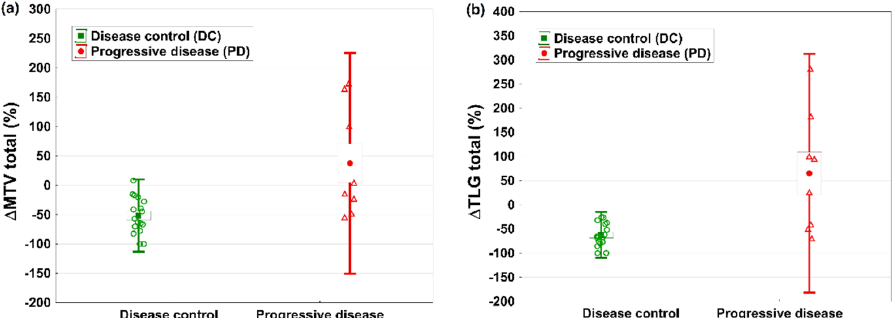
Figure 1. Mean changes in PET parameters ( a ) metabolic tumor volume (MTV) and ( b ) total lesion glycolysis (TLG) in patients with DC and PD according to EORTC; EORTC = European Organization for Research and Treatment of Cancer; DC = disease control; PD = progressive disease.